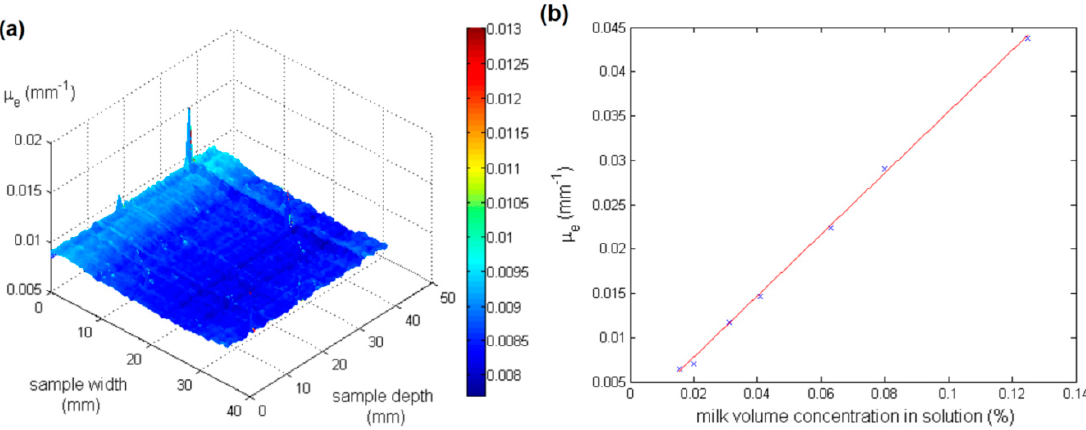
Figure 8. ( a ) Calculated µ e of a diluted homogeneous milk solution, which is fairly constant throughout; ( b ) Calculated µ e of di ff erent diluted milk samples plotted as a function of milk volume concentration (%) in the sample. Image data from [22] .